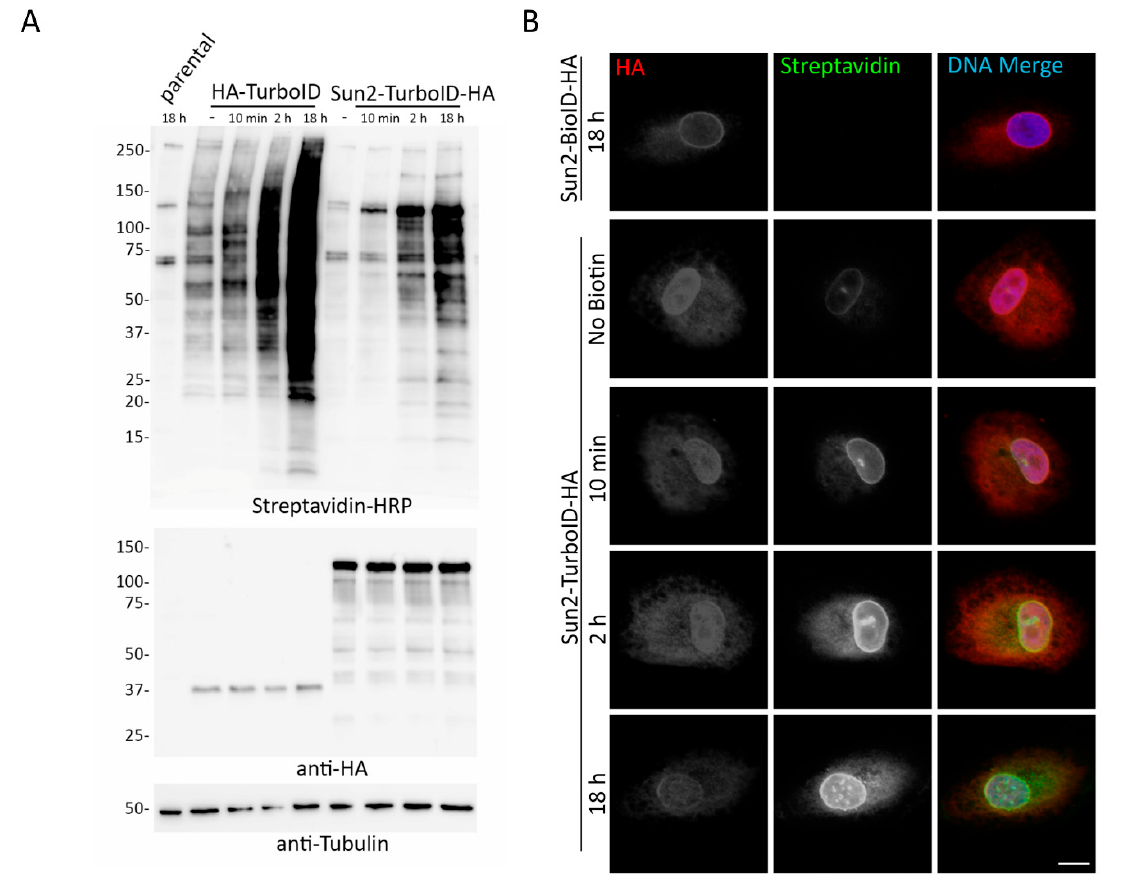
Figure 10. TurboID is relatively stable within the ER lumen and biotinylates more e ffi ciently than BioID. ( A ) Western blot analysis of A549 cells stably expressing HA-TurboID or HA-TurboID-Sun2 in the absence or presence (10 min, 2 h, or 18 h). A549 parental cells incubated with biotin for 18 h was used as a control for basal biotinylation levels. ( B ) Sun2-BioID-HA showed no biotinylation